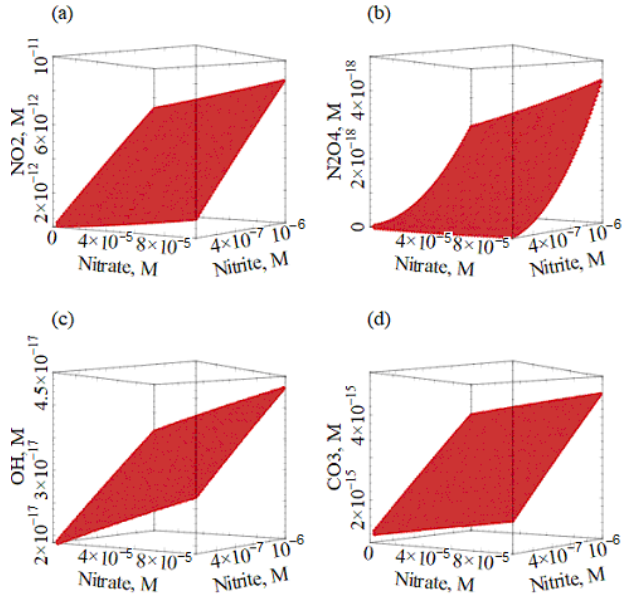
Figure 3. Modeled steady-state concentrations of • NO 2 ( a ), N 2 O 4 ( b ), • OH ( c ), and CO 3 •− ( d ) as a function of nitrate and nitrite concentrations. Other conditions: 5 m water depth, 1 mM HCO 3 − , 10 µ M CO 32 − , 1 mg C L − 1 DOC, and 22 W m − 2 sunlight UV irradiance, which is equivalent to fair weather, 45°N latitude 15 July, at 9 a.m. or 3 p.m.